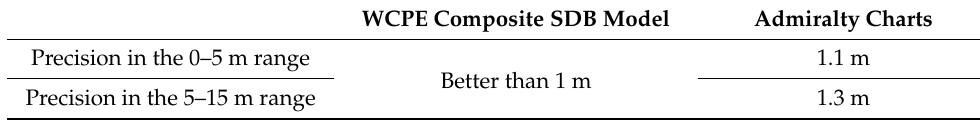
Table 3. Comparison between precisions offered by WCPE and admiralty charts in Qatar.